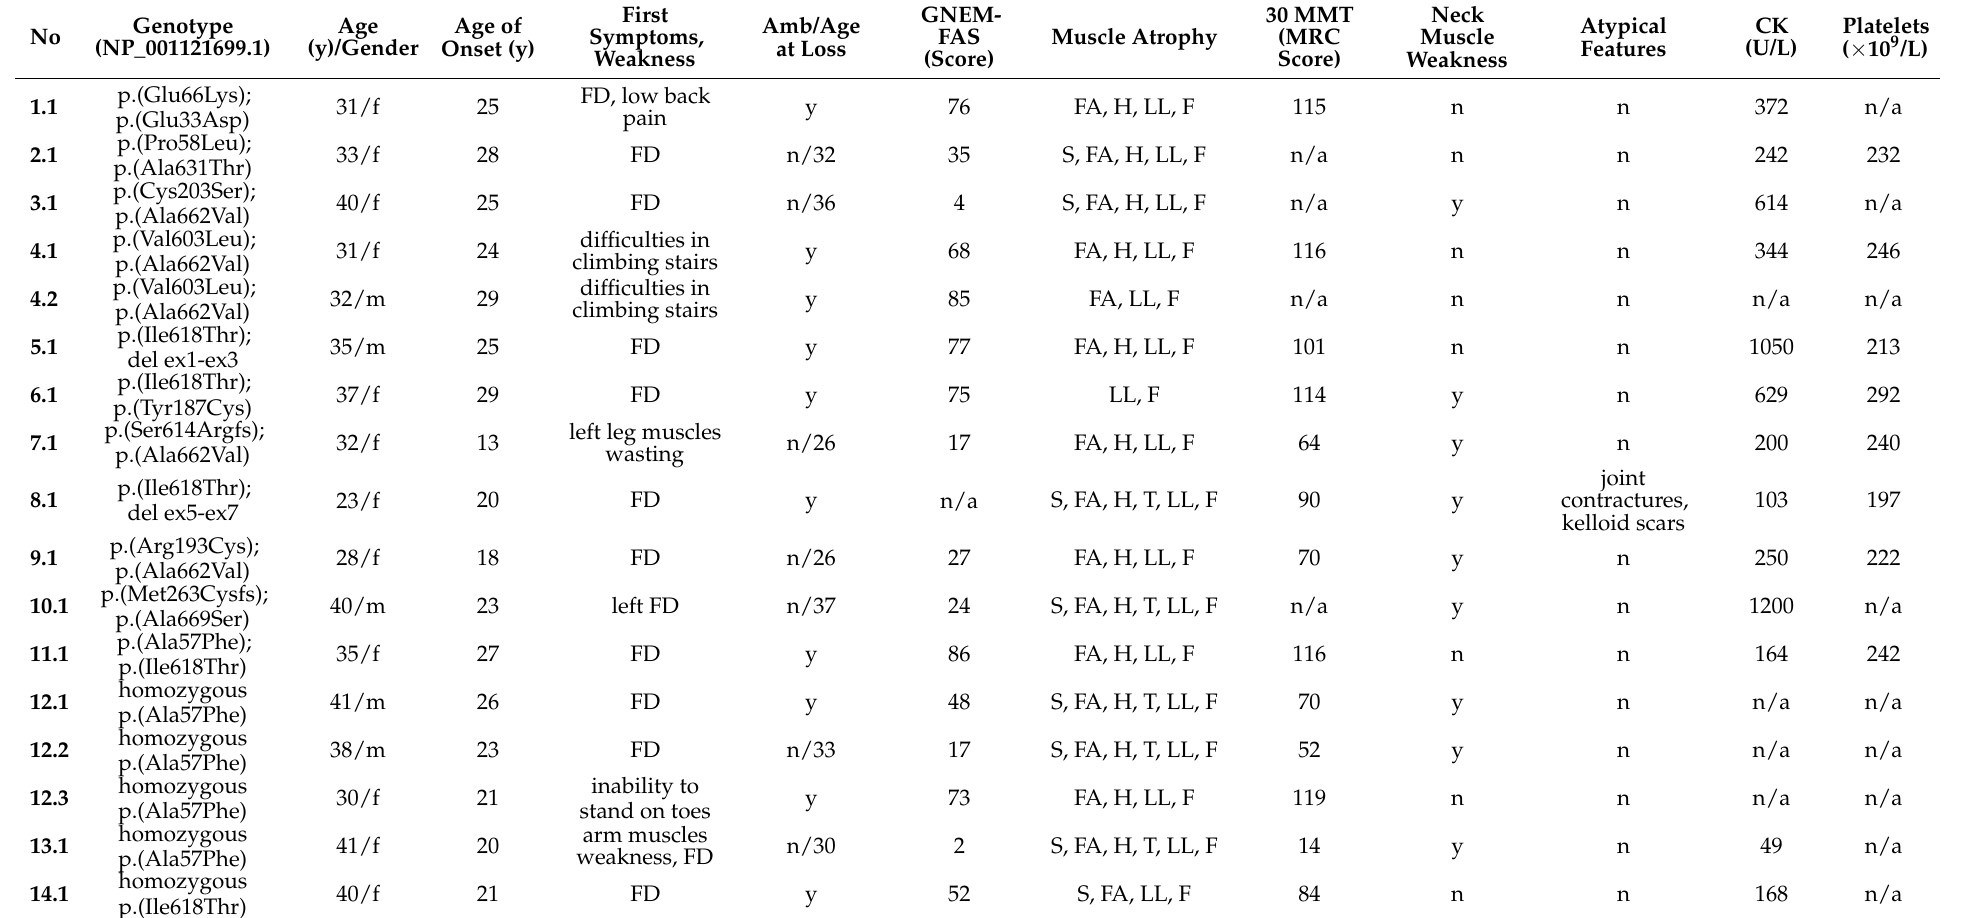
Table 2. Clinical features and molecular data of Russian patients with GNE